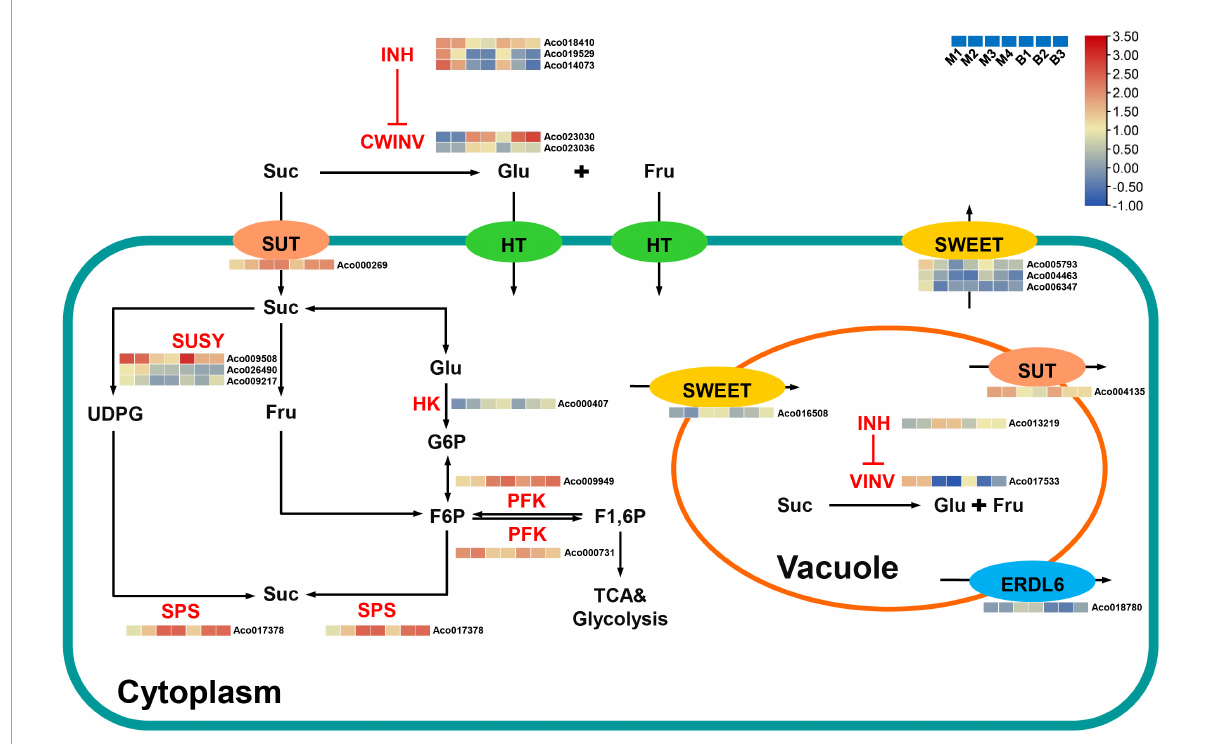
FIGURE7 Regulatory model and expression levels of the genes related to sucrose metabolism and accumulation in pineapple fruits. From blue to red in the heatmap indicates the expression levels of the genes ranging from low to high in two pineapple cultivars throughout fruit development. M1, M2, M3, and M4 represented fruit flesh samples for M at 40, 80, 100, and 120 DAA, respectively, and B1, B2, and B3 represented fruit flesh samples for B at 40, 80, and 100 DAA, respectively. CWINV, cell wall invertase; CWINH, cell-wall invertase inhibitor; VINV, vacuolar acid invertase; VINH, vacuolar acid invertase inhibitor; SUSY, sucrose synthase; SPS, sucrose phosphate synthase; HK, hexokinase; PFK, phosphofructokinase; SUT, sucrose transporters; SWEET, sugars will eventually be exported transporter; ERDL6, glucose exporter early response to dehydration like 6; Suc, sucrose; Glc, glucose; Fru, fructose; UDPG, UDP-glucose; G6P, glucose-6-phosphate; F6P, fructose-6-phosphate; F1, 6P, fructose-1,